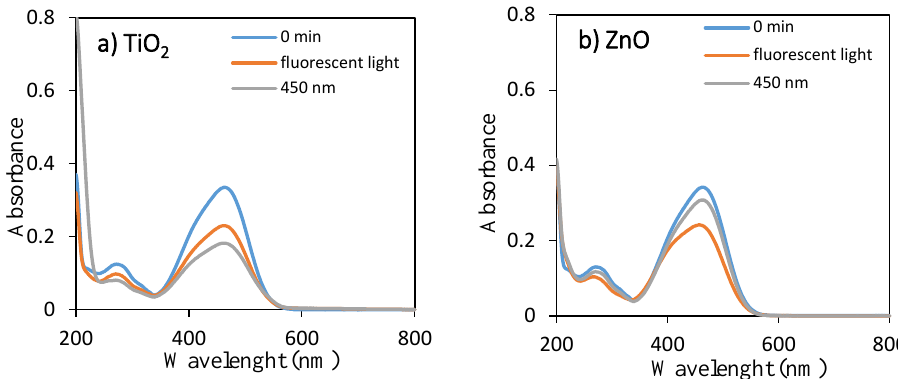
Figure 2. UV–visible spectra of aqueous solutions of MO for 0 min and 360 min using ( a ) TiO 2 and ( b ) ZnO under fluorescent and LED lights.